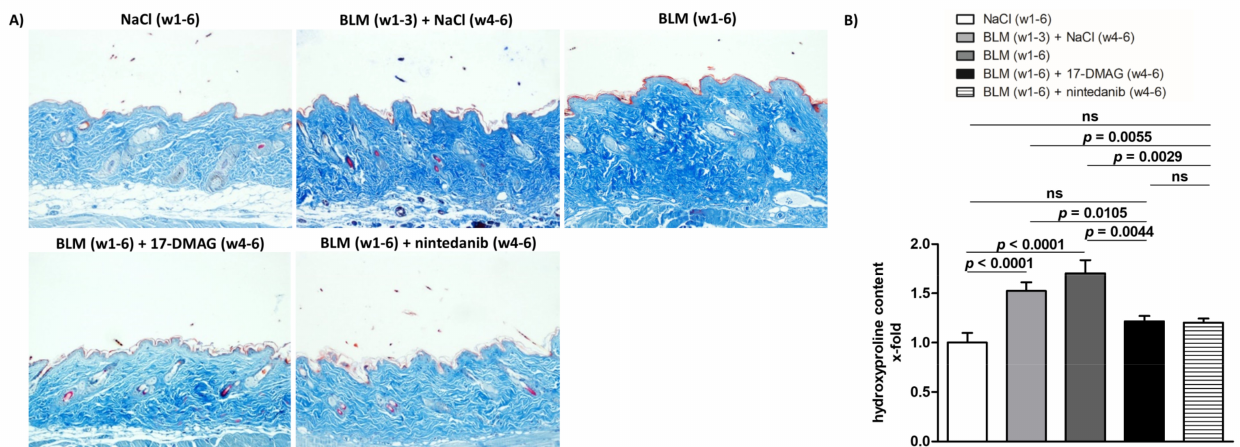
Figure 3. Treatment with 17-DMAG prevents further progression and may induce regression of collagen accumulation induced by bleomycin. ( A ) Representative images of Blue Masson’s Trichrome-stained skin sections are shown. Collagen bundles are stained blue. Original magnification × 100. ( B ) Treatment with 17-DMAG prevents further progression and may induce regression of collagen accumulation (analyzed by hydroxyproline content) induced by bleomycin. The extent of the protective effects of 17-DMAG is comparable to the effect of the treatment with nintedanib. Columns represent the mean and whiskers represent the standard error of the mean. w, week; NaCl, sodium chloride; BLM, bleomycin; 17-DMAG, 17-dimethylaminoethylamino-17-demethoxygeldanamycin (inhibitor of heat shock protein 90); ns, not significant ( p ≥ 0.05); n = 8 mice in each group.